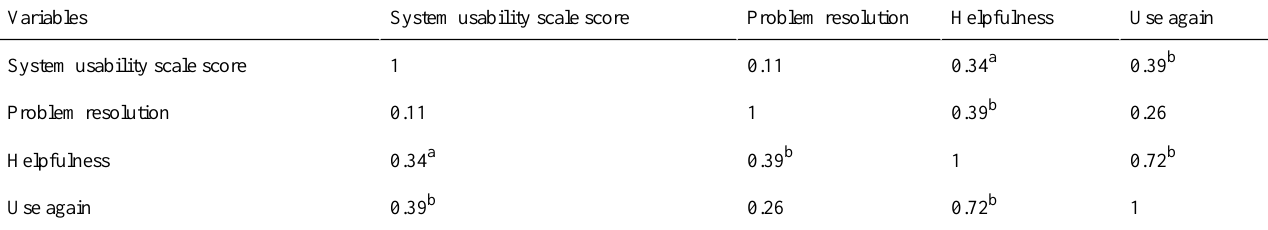
Table 4. Pearson Correlations for postintervention ELIZA ratings of system usability, problem resolution, helpfulness, and willingness to use ELIZA again.